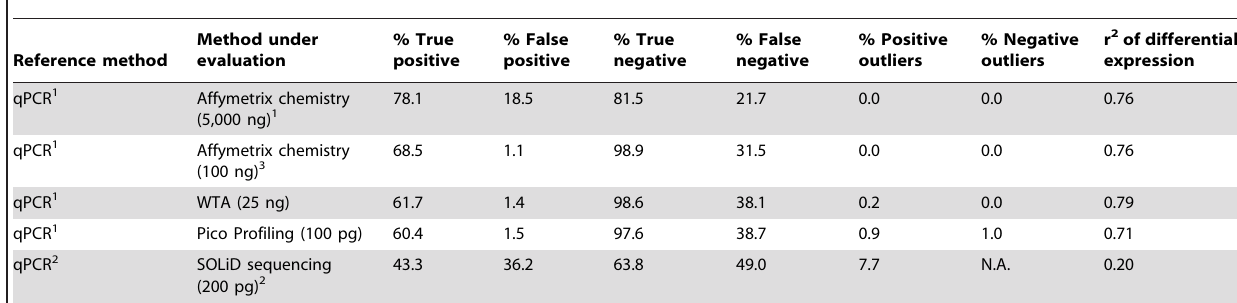
Table 2. Comparison of expression profiling results generated from small amounts of RNA versus